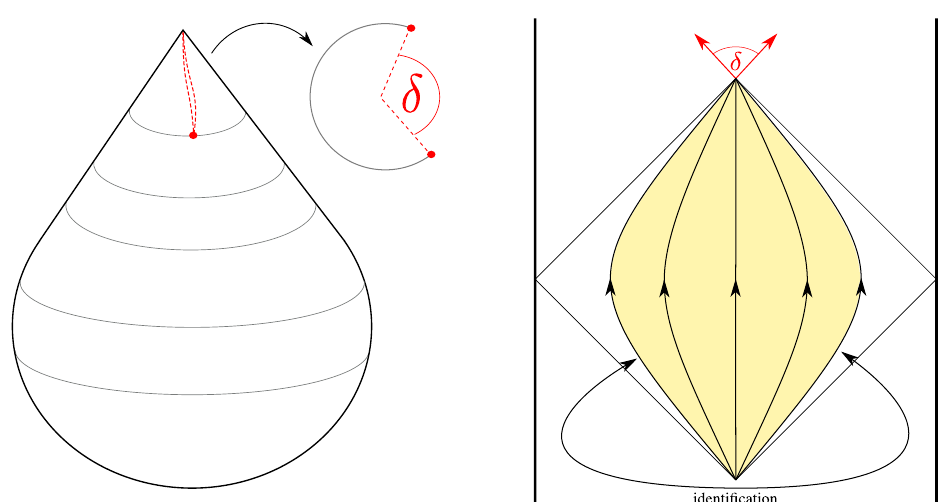
Figure 14: Left: Illustration for the derivation of the Gauss-Bonnet-theorem in the presence of conical singularities. We consider a two dimensional surface, either Eu- clidean or Lorentzian, with a conical singularity, and introduce a cut (red dashed lines) from the conical singularity to a point elsewhere in the surface, where it is lo- cally smooth. The conical deficit of the singularity (or its Lorentzian analogue) is δ . Right: Construction of the lemon’s induced metric by taking a region between two timelike geodesics in AdS and identifying the boundary. At the intersection of the 2 two geodesics that form the boundary of the region, their two tangent vectors cross with a relative boost factor δ , which is the Lorentzian analogue of the deficit angle for the conical singularity that is formed at this location due to the identification. = ± π The two vertical lines indicate the AdS boundaries at θ 2 2 2